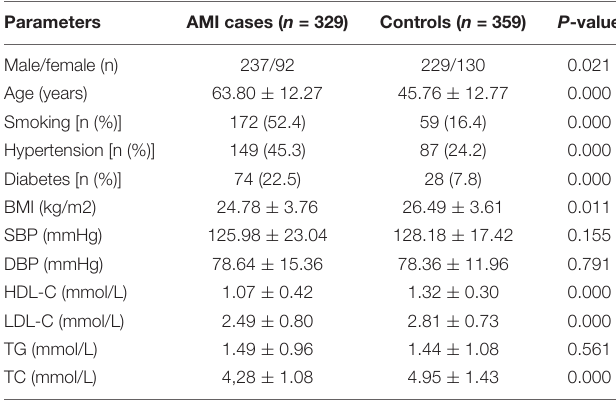
TABLE 2 | Characteristics of the study